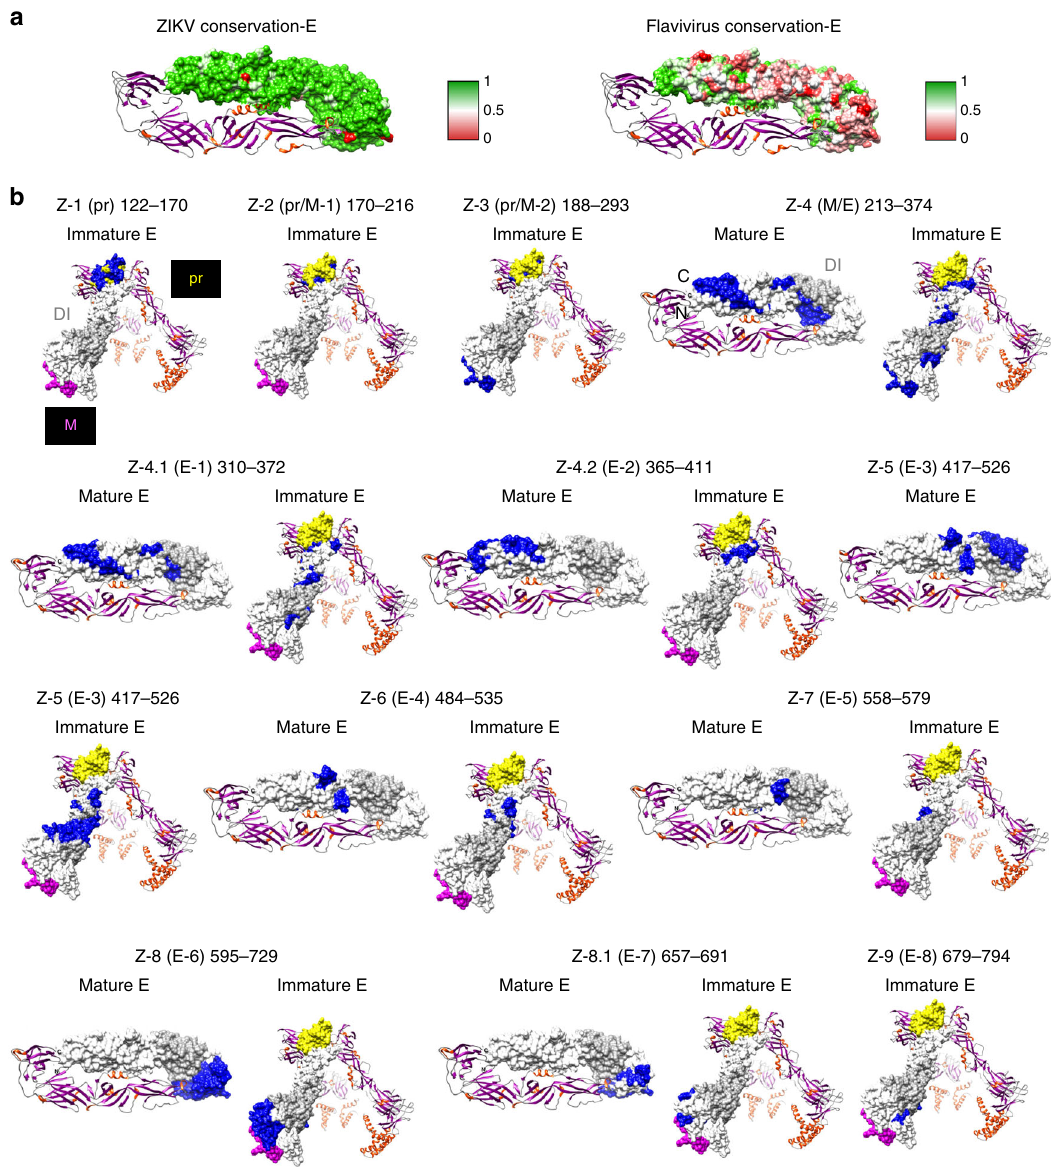
Fig. 3 Structural representation of antigenic sites identi fi ed in ZIKV-E protein. a (Left panel) Heat map showing sequence conservation on one monomer chain of mature ZIKV-E protein structure (PDB# 5JHM) based on comparison with several Zika virus (ZIKV) isolates (Paraiba, Uganda-1947, Nigeria-1968, Senegal-2001, Micronesia-2007, and Brazil-2016 strains) and (right panel) ZIKV vs. other fl aviviruses (Dengue virus (DENV) 1 to 4, West Nile virus, Yellow Fever virus and ZIKV). The heat map has been color coded from red (0) to green (1), where green denotes complete conservation. b Antigenic sites within ZIKV-prM/E identi fi ed by the GFPDL analysis are depicted in blue on the structures of both immature (PDB 5U4W) and mature ZIKV-E (PDB 5JHM). Domain I is shaded in light gray (PDB 5JHM), pr domain is shaded in yellow and M in pink (PDB 5U4W). PDB Structure# 5U4W encompasses residues 288 – 794 and PDB structure# 5JHM encompasses residues 313 – 699 based on ZIKV_ICD polyprotein sequence (Supplementary Fig.